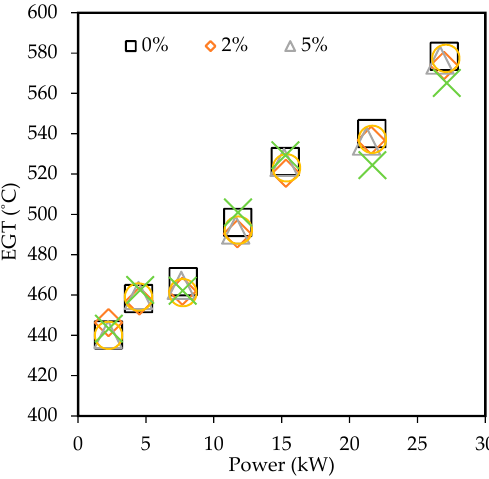
Figure 6. Variations in exhaust ‐ gas temperature (EGT) of tested fuel types.